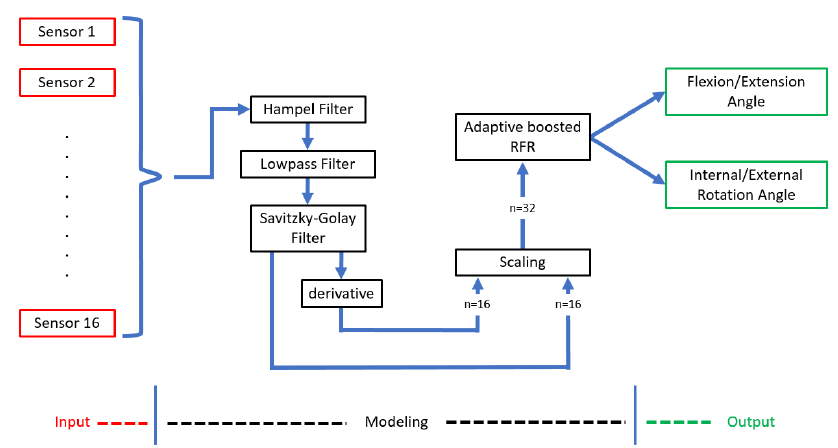
Figure 4. Flow chart of the pipeline used to predict knee